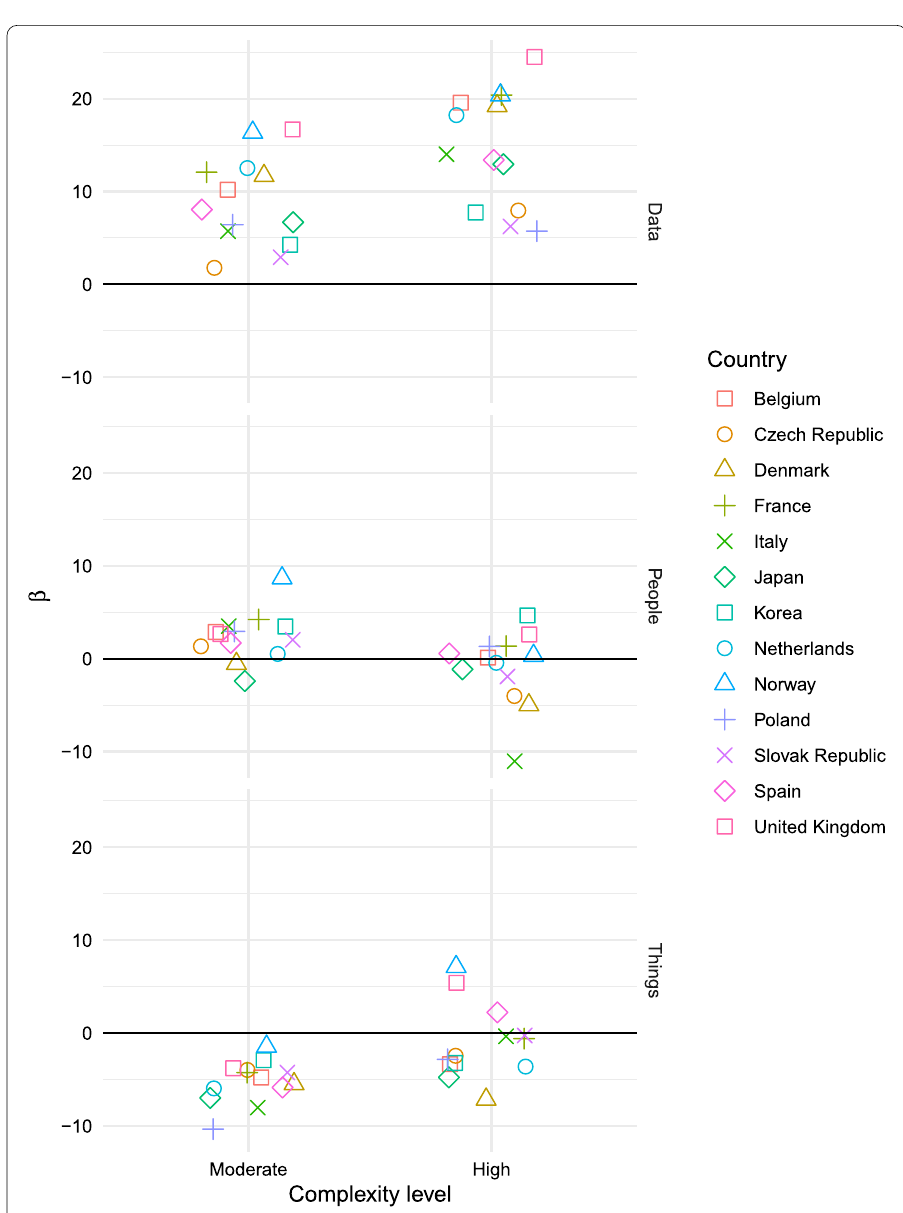
Fig. 5 Visualization of complexity regression coeffcients in Table 6. The points have been horizontally jittered to avoid overplotting. Source: PIAAC 2012, DOT index, ISCO-08